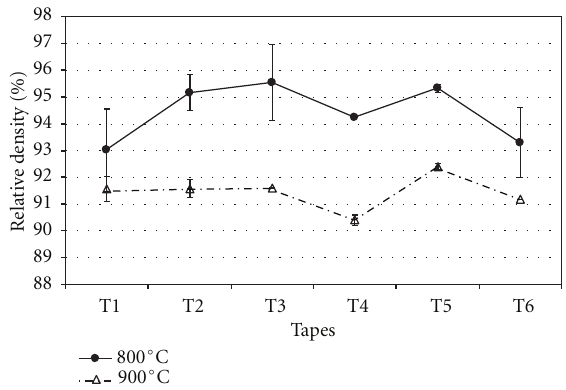
Figure 6: Densification of LZSA laminates prepared from di ff erent tapes at 800 and 900 ◦